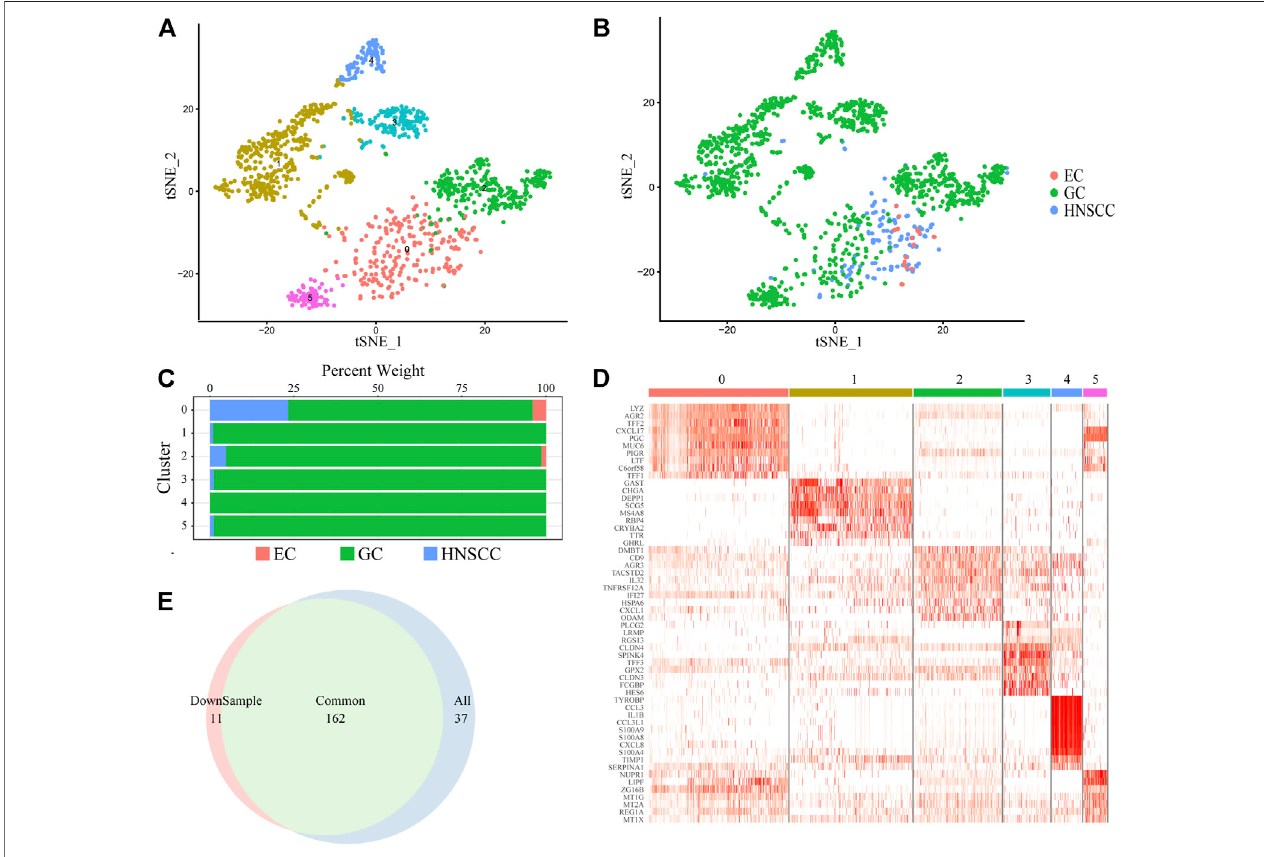
FIGURE 2 | Cancer stem cell clusters. (A) t-SNE plot of 1,586 CSC cells color-coded by sub-clusters. (B) t-SNE plot color-coded for cancer type of origin. (C) Histogramofcellnumbersineach CSCcancertype. (D) Heatmap oftheexpression patternofsixsub-clustersinCSC. (E) VenndiagramofDEGsindownsampleCSCs and All